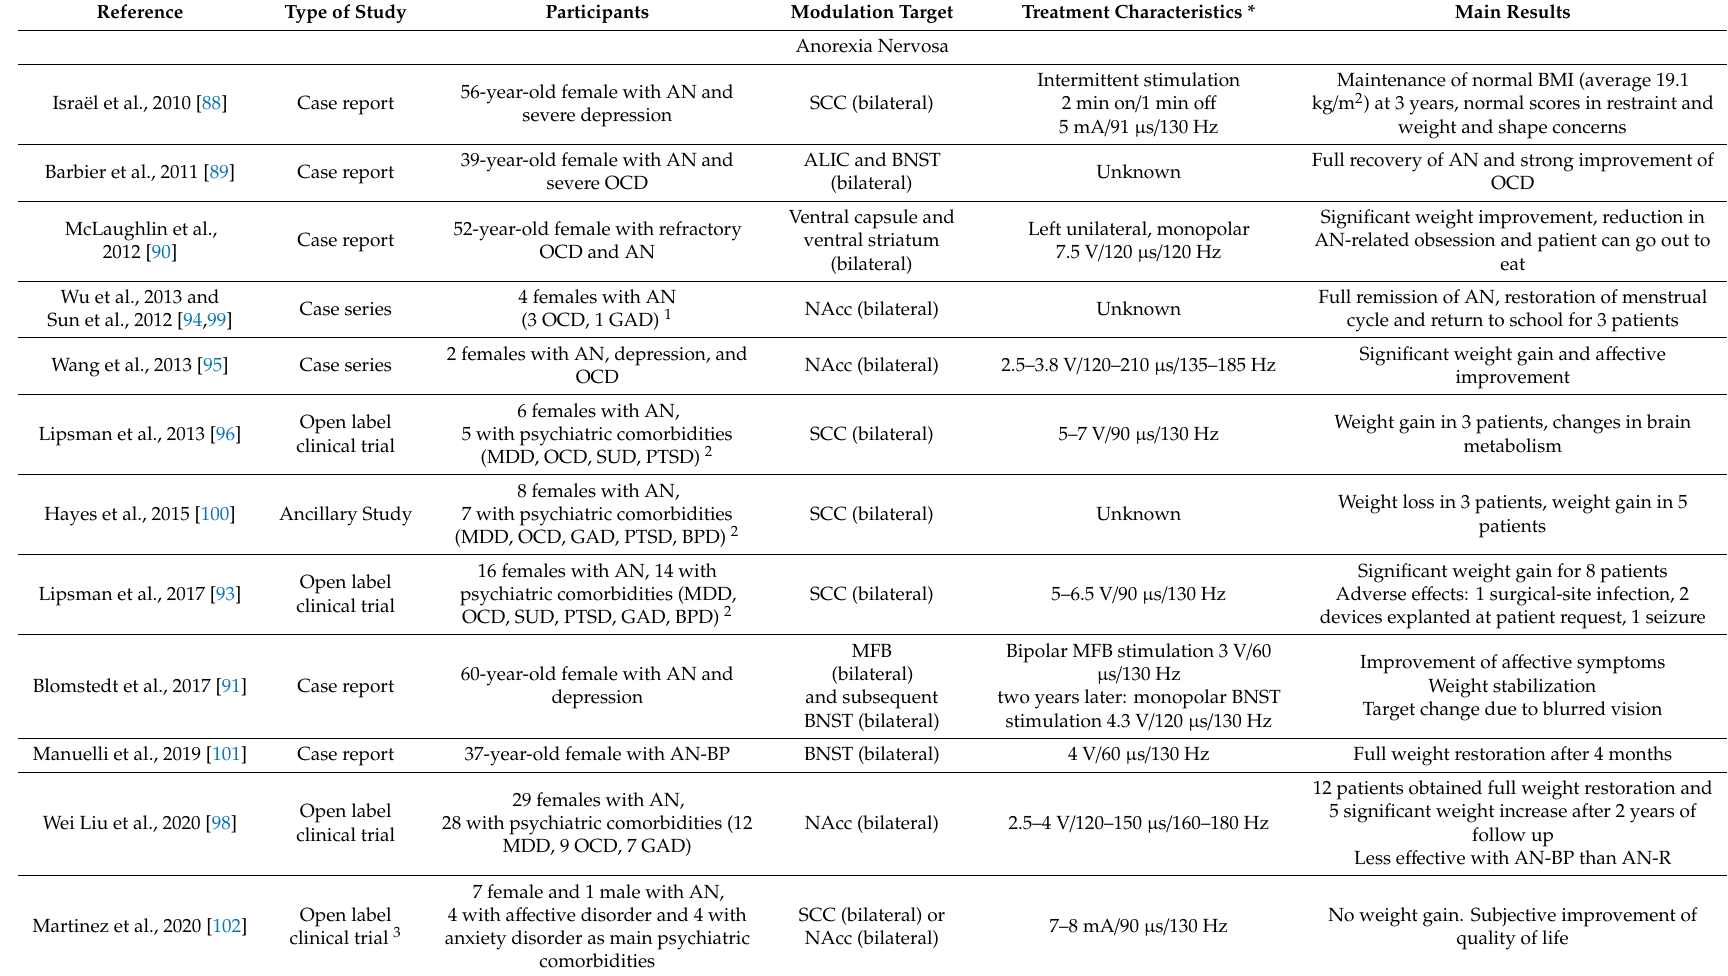
Table 4. Deep brain stimulation (DBS) in eating